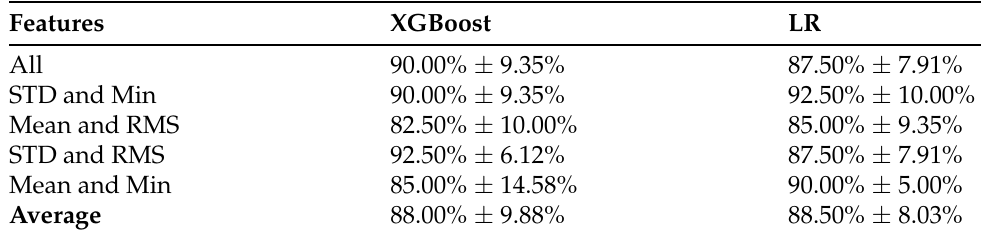
Table 3. XGB and LR accuracy for grasping.